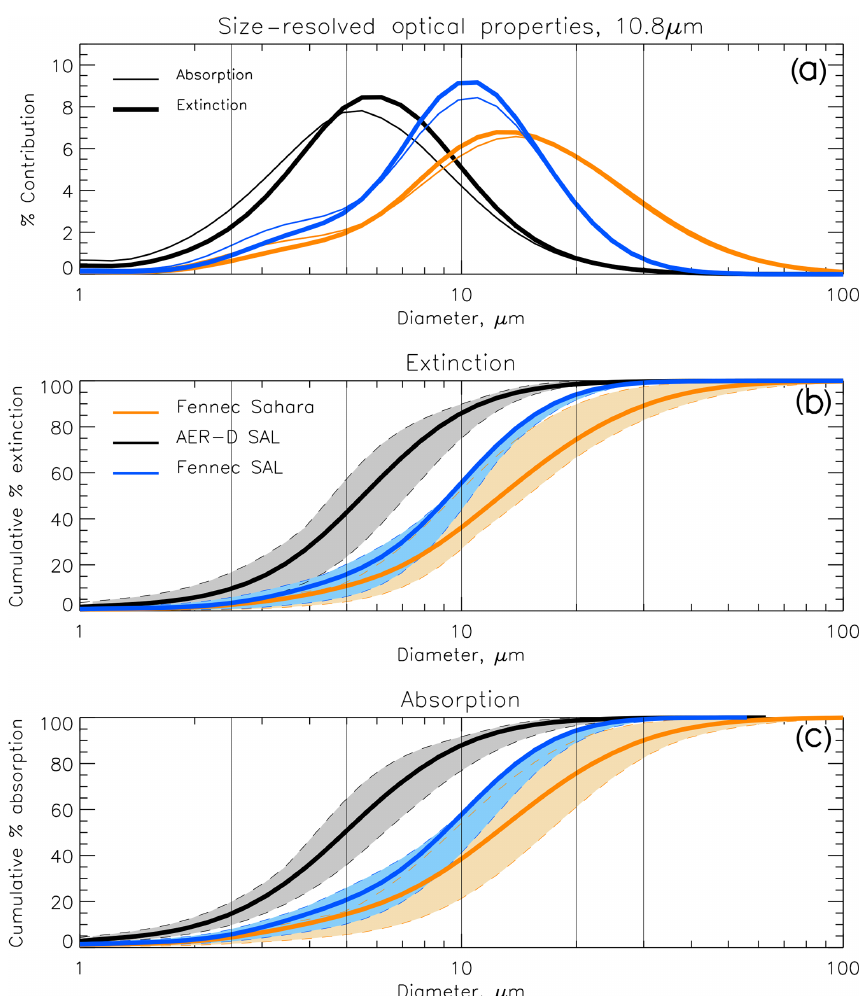
Figure 8. Size-resolved contribution to total absorption (thin lines) and extinction coefficient (bold lines) calculated for AER-D-SAL (black), Fennec-SAL (blue), and Fennec-Sahara (orange) at 10.8µm using the Volz RI dataset. (a) Percentage contribution as a function of diameter, (b) cumulative percentage extinction as a function of diameter, and (c) cumulative percentage absorption coefficient as a function of diameter. In (b) and (c) , shading bounded by dashed lines shows the uncertainty due to the range of RI datasets and PSD variability observed in each observational campaign. Vertical lines indicate diameters of 2.5, 5, 10, 20, and